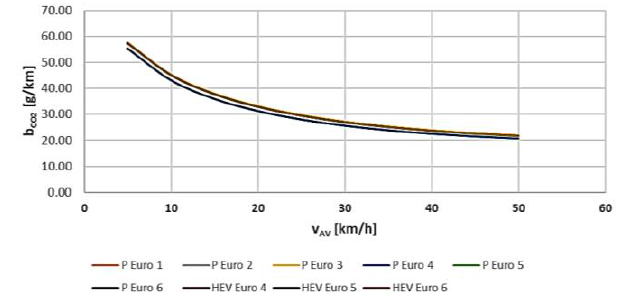
Fig. 2. CO 2 emission from petrol PCs for Euro standards depending on average